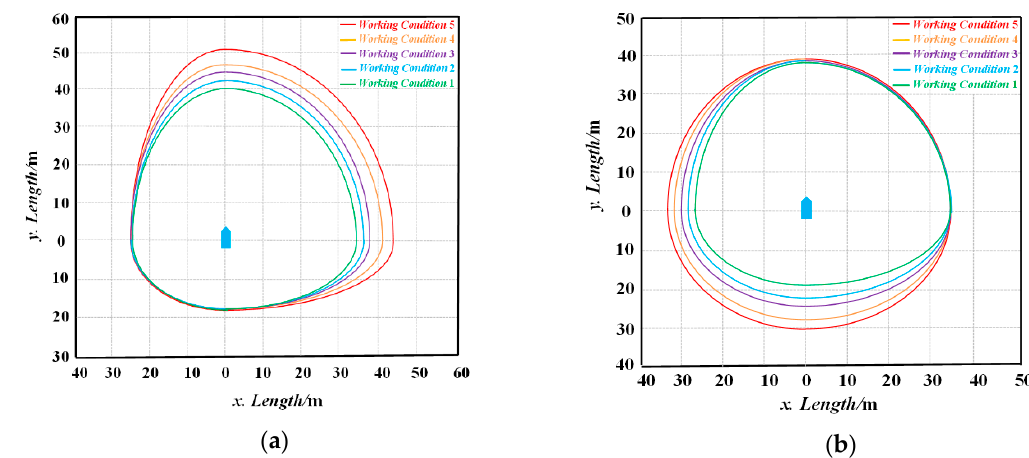
Figure 10. Radius changes of the dynamic navigation safety domain (DNSD) in the head-on situation: ( a ) Under the first angle groups; ( b ) Under the second angle groups.